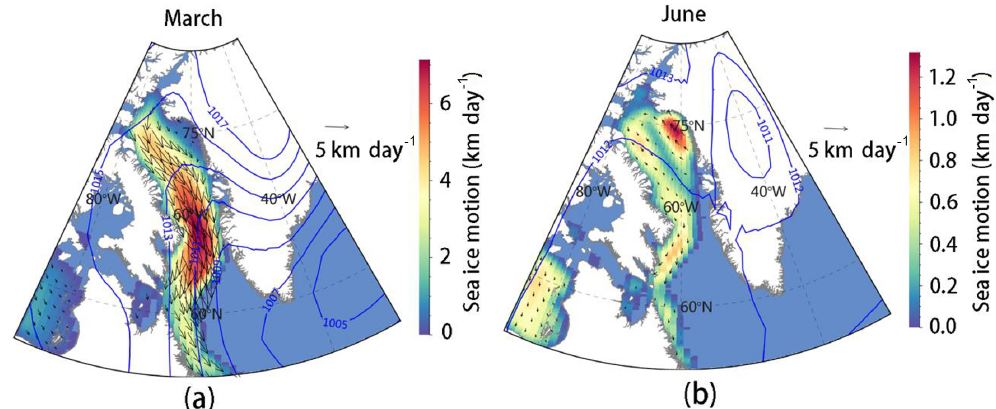
Figure 8. Sea ice drift patterns (arrows) in (a) March and (b) June 2016. Background color denotes the magnitudes of sea ice speeds. Thick superimposed curves represent the SLP distribution patterns of the corresponding